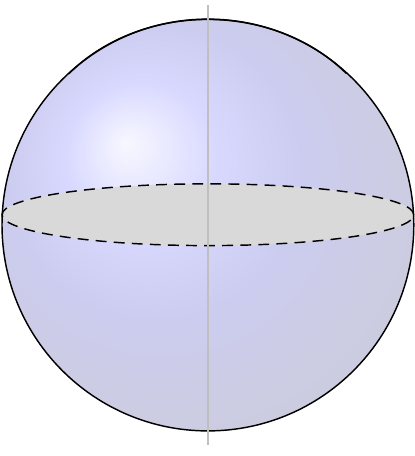
Figure 2 . Cosmic string and membrane intersecting the celestial